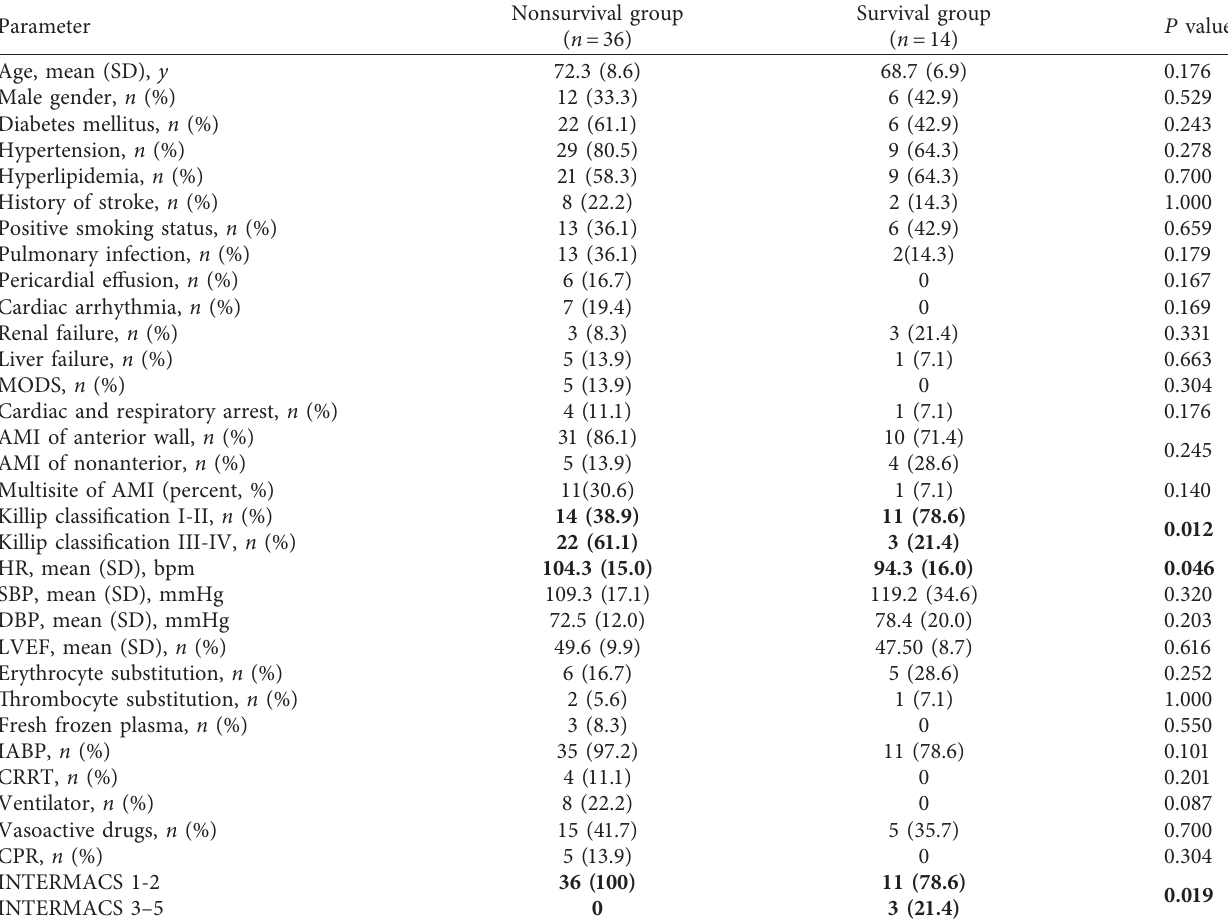
Table 1: Baseline characteristics of patients with ventricular septal rupture.